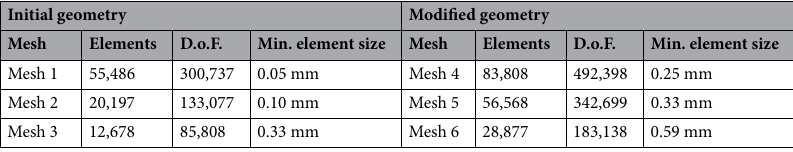
Table 3. Resolution of the considered meshes. D.o.F .: degrees of